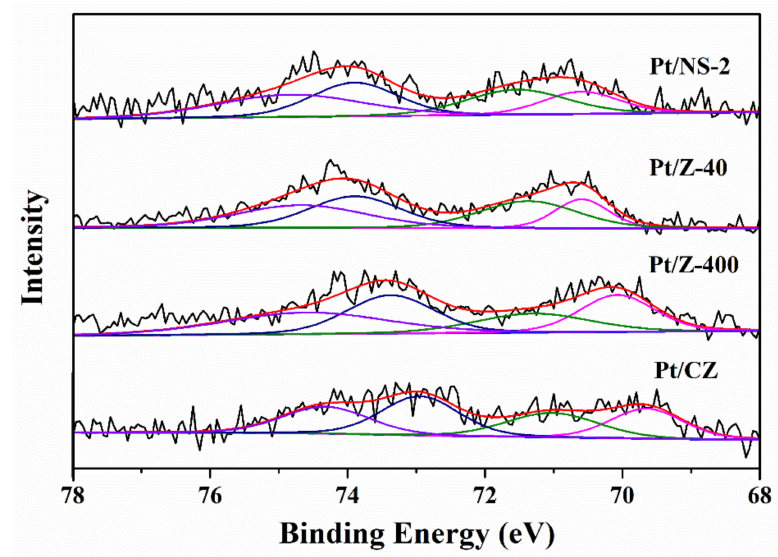
Figure 7. Pt 4f XPS spectra of di ff erent Pt-loaded zeolite catalysts.